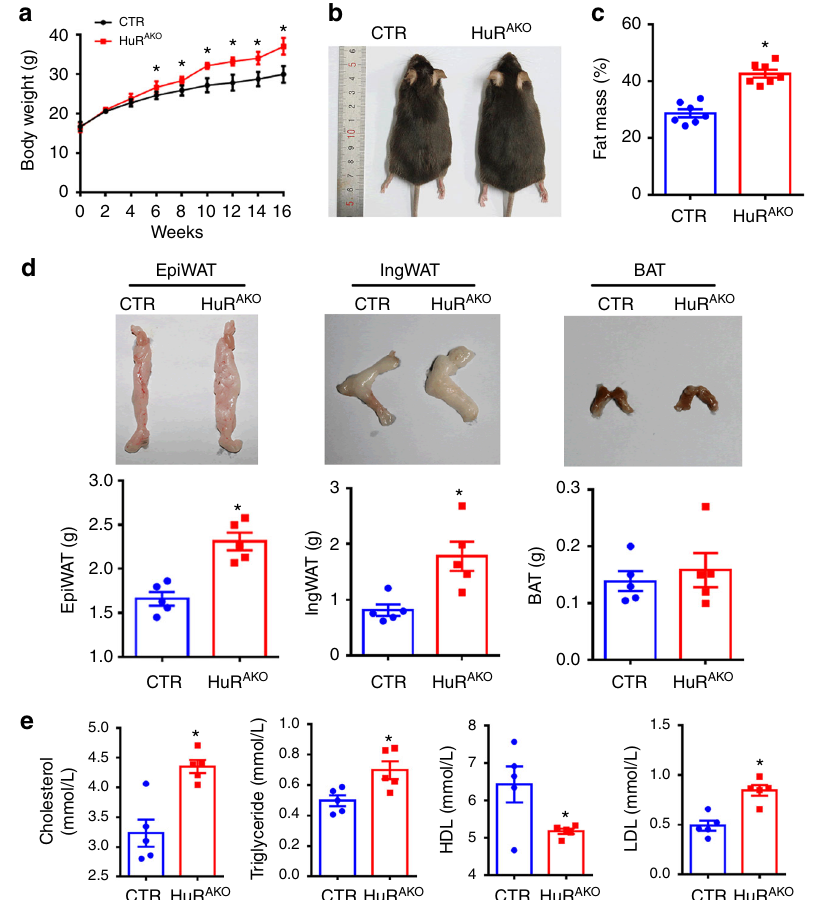
Fig. 2 Adipose-speci fi c HuR ablation sensitizes mice to obesity. a Body weight of control and HuR AKO mice fed an HFD ( n = 10), *comparison of HuR AKO vs. control. b Representative photographs of control and HuR AKO mice fed an HFD. c Fat mass analysis of control and HuR AKO mice fed an HFD ( n = 7), *comparison of HuR AKO vs. control. d Representative photographs of fat pads (epiWAT, ingWAT and BAT) (top) and quanti fi cation (bottom) ( n = 5), *comparison of HuR AKO vs. control. e Serum lipid pro fi les (cholesterol, triglycerides, HDL and LDL) in control and HuR AKO mice fed an HFD ( n = 5), *comparison of HuR AKO vs. control. Data are represented as mean ± SEM. Signi fi cance was determined by Student ’ s t test analysis, * P < 0.05. Source data are provided as a Source Data fi